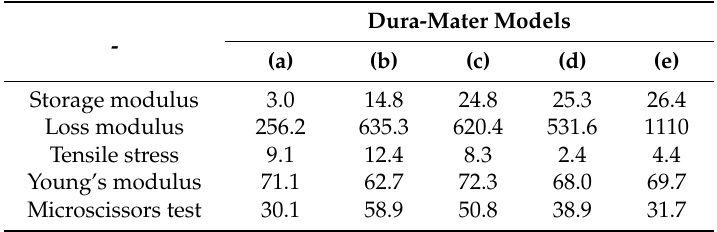
Table 2. Error rate of evaluation test (error rate